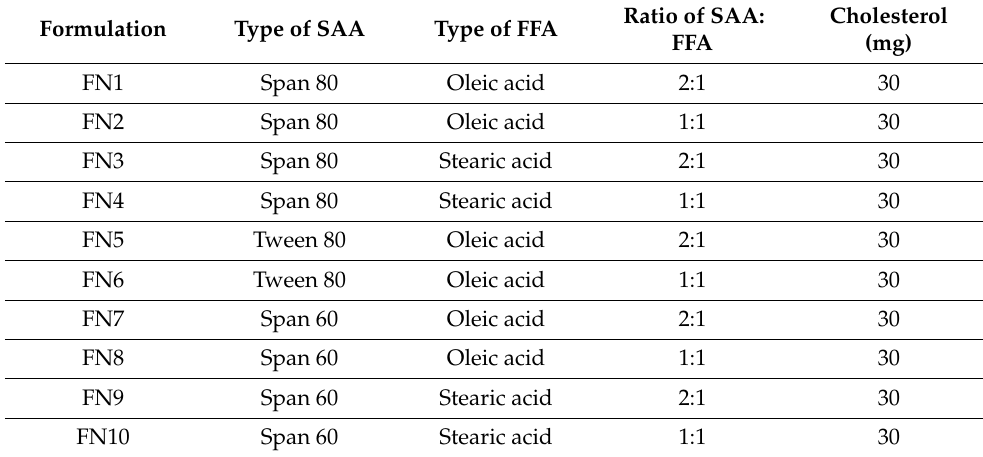
Table 5. Composition of different novasome